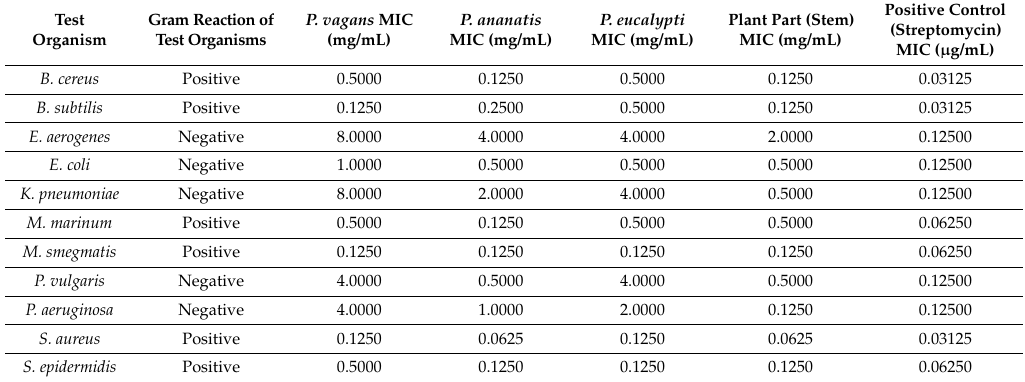
Table 2. Minimum Inhibitory Concentration (MIC) values of the antibacterial activity test carried out on the secondary metabolites, extracted from the identified endophytes and the plant